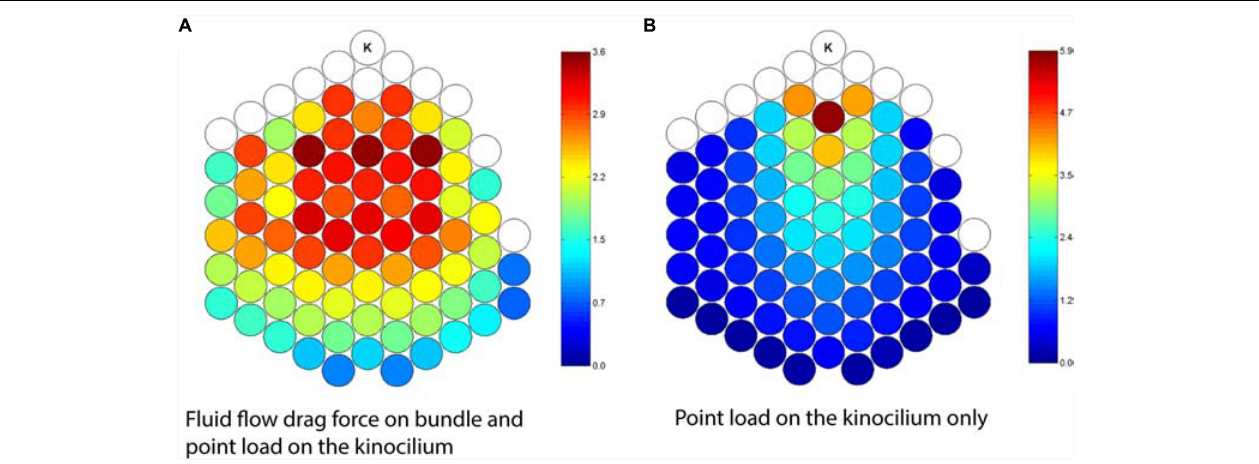
FIGURE 15 | Striolar Type I hair cell bundle viewed from above with different deflection loadings. In these diagrams, each circle represents a stereocilium or kinocilium (designated K), with stereocilia without a tip-link are in white. Tip-link tension color-scales are shown to the right of each figure in terms of pN (piconewtons) force above a resting tension of 20 pN. The resting tension is produced by the molecular motors that hold the tension at a value just below channel open probability with the bundle at rest. Any stereocilium with an increased tip-link tension of 1.0 pN above resting is considered at 50% open probability. The Bundle to the left (A) is loaded with both fluid flow producing a drag force on the bundle and a point load on top of the kinocilium. All tip-links in this bundle are well above the 50% open probability tension and are considered open. The bundle to the right (B) is only loaded with a point force load on the kinocilium top, and with no fluid flow drag force loading. A large fraction of the tip-links around the periphery are well below the 50% open probability range. Those at the bottom are not tensioned at all. Only the central portion of the bundle has well opened tip-link channels. Tip-link tensions are shown after a full dynamic loading time period of 1 ms (Nam et al.,